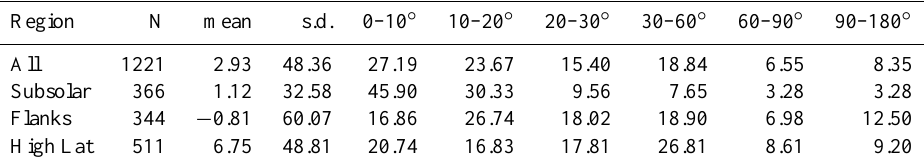
Table 4. Distribution of angular differences, for data subject to 5-min boxcar smoothing. Format as in Table 3. Region All Flanks